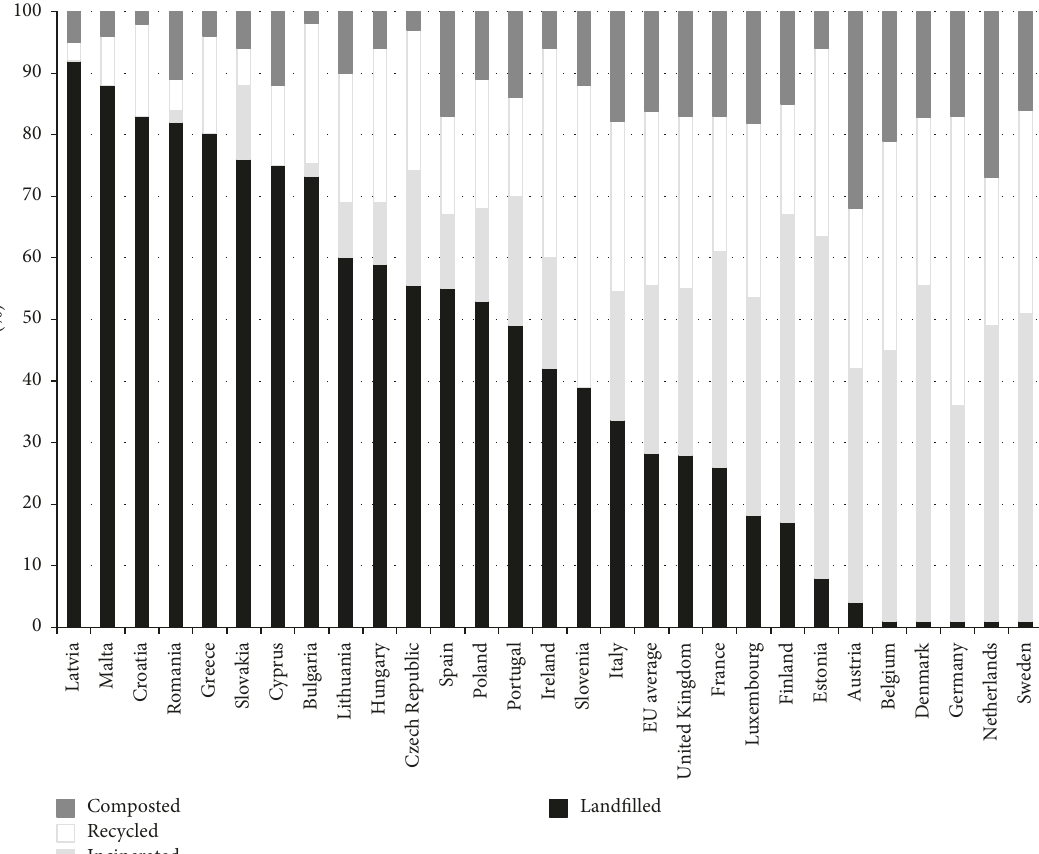
Figure 1: Share of the different treatment options in the 28 EU countries in the year 2014